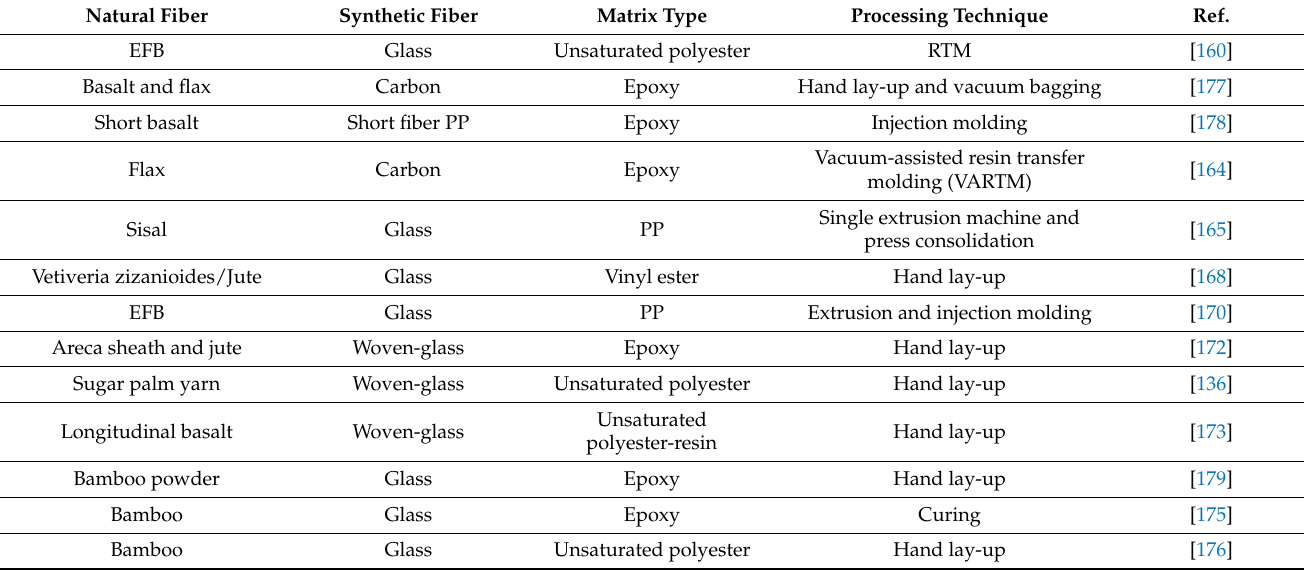
Table 5. Summary of works on hybrid natural fiber/synthetic fiber-reinforced polymer composites.